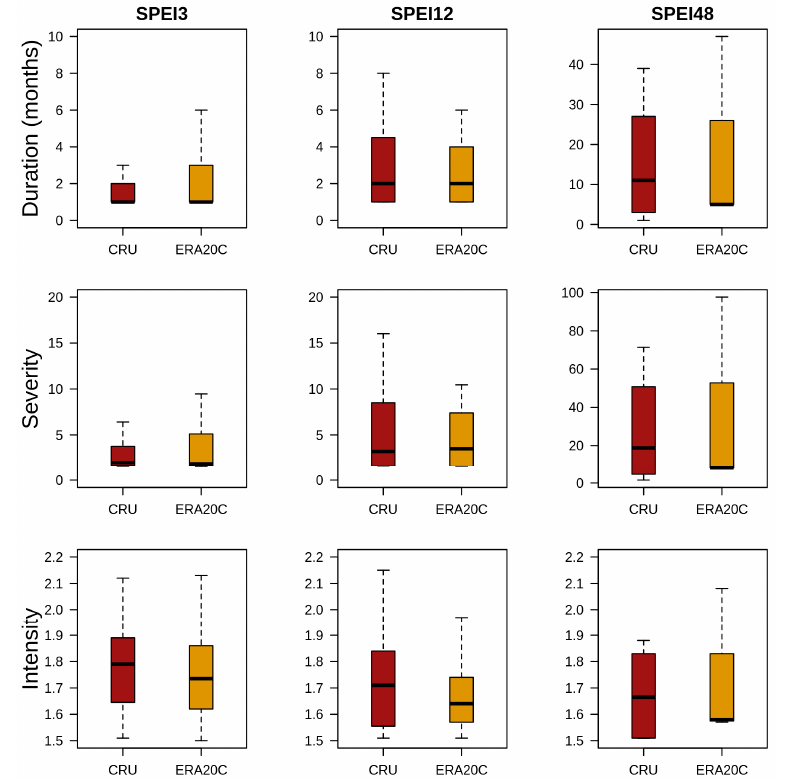
Figure 6. Boxplots of mean duration (months), severity and intensity of severe drought events in the ESP region, for observed data (CRU—red) and reanalysis data (ERA20C–yellow).